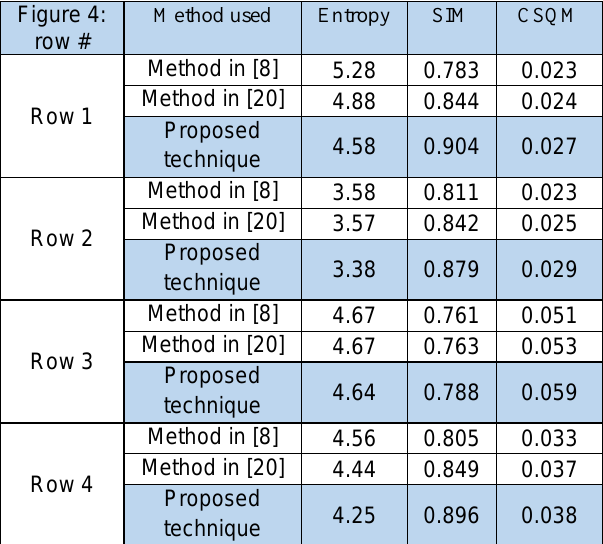
Table 3. Inpainted image quality assessment comparison using Entropy, SIM, and CSQM. Figure 4: